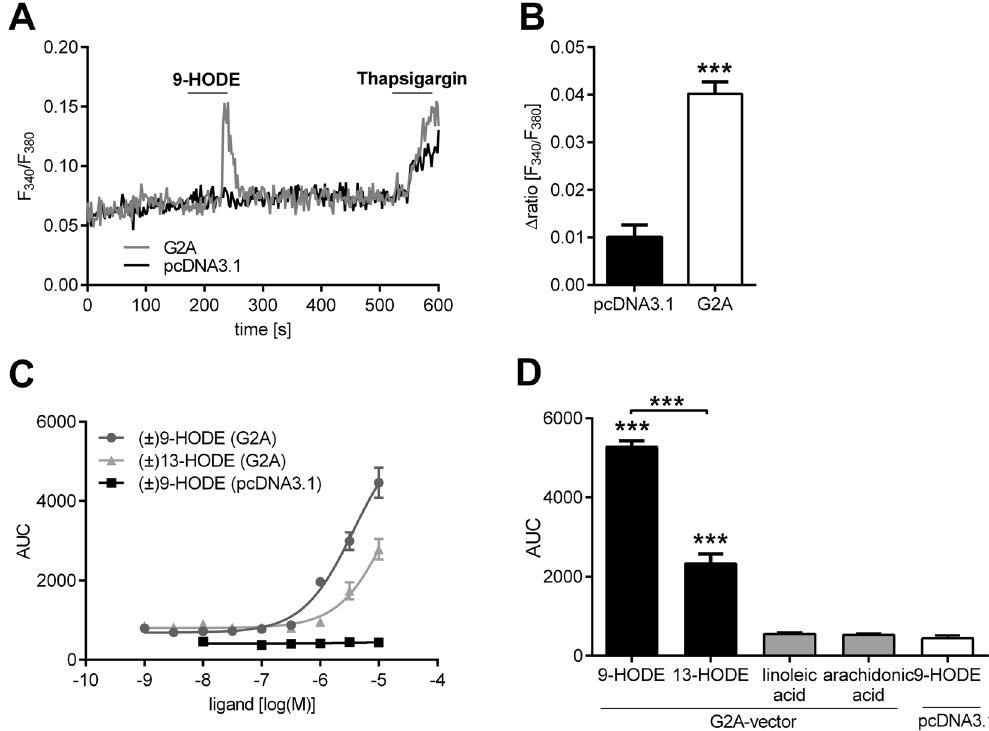
Figure 3. 9-HODE activates the G2A-receptor (GRP132). ( A , B ) Shown are calcium concentrations of HEK-293 cells transfected with G2A-vector or pcDNA3.1 (empty vector) stimulated with 9-HODE (1 µ M). Thapsigargin (1 µ M) was used as positive control. ( A ) Shows a representative trace and ( B ) the quantitative analysis presented as mean ± SEM with n = 32–46 cells per condition. *** p < 0.001 unpaired student’s t-test. ( C ) Dose-response analysis of COS-1 cells co-transfected with aequorin- and G2A-expressing vector or pcDNA3.1 (empty vector). Seen is the calcium flux as area under curve (AUC) at different 9-HODE and 13-HODE concentrations [10 − 9 –10 − 5 M]. Data are presented as mean ± SEM from n = 3 measurements. ( D ) COS-1 cells cotransfected with aequorin- and G2A-expressing vector stimulated with 9-HODE (10 µ M), 13-HODE (10 µ M), linoleic acid (30 µ M) and arachidonic acid (30 µ M). Shown is the calcium flux as mean of area under curve (AUC) ± SEM with n = 3 measurements; *** p < 0.001 one-way ANOVA with Bonferroni post-hoc